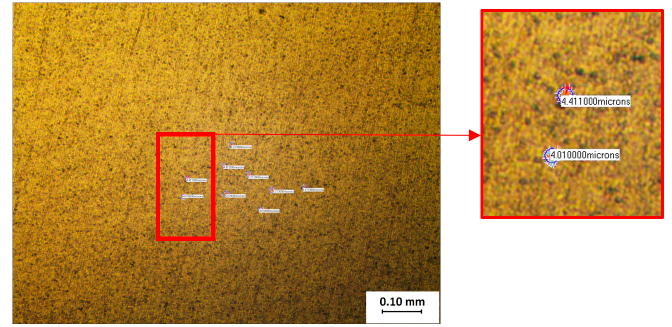
Figure 6. Demonstration of grain size measurement.